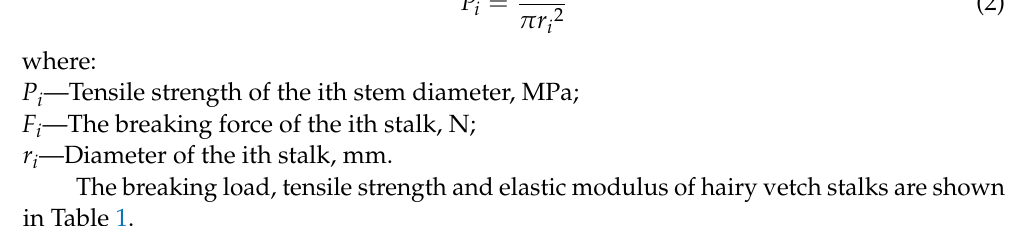
Figure 5. Stretching curve of hairy vetch stalk.